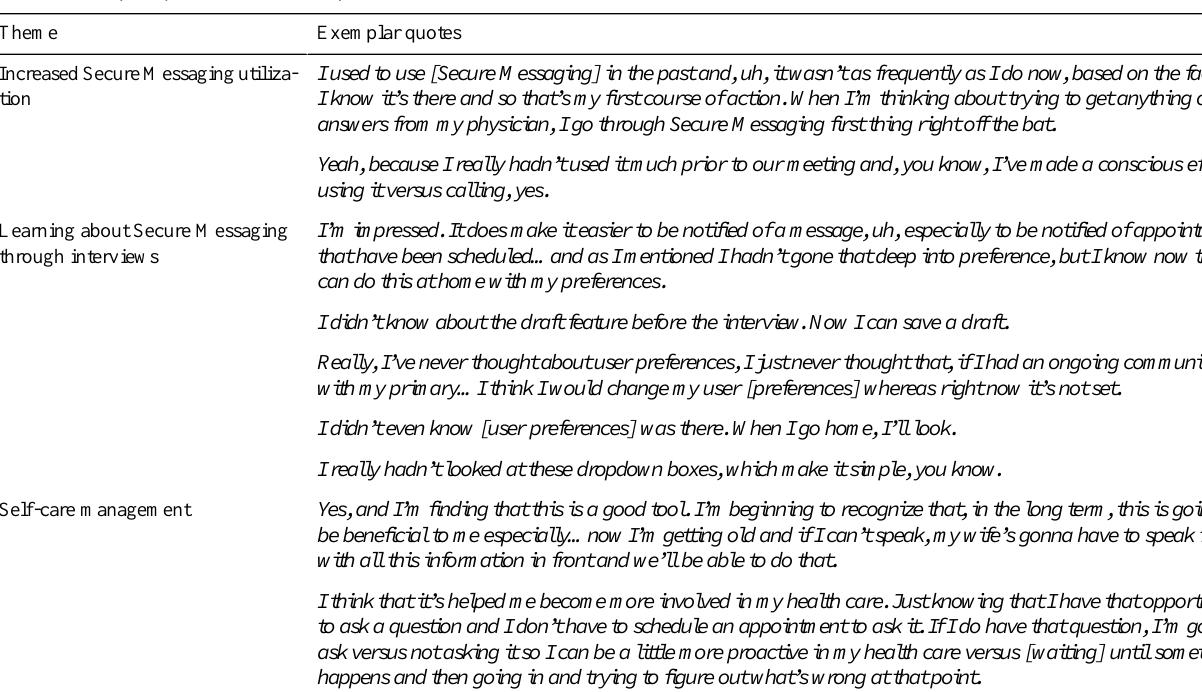
Table 7. Exemplar quotes from follow-up interviews.